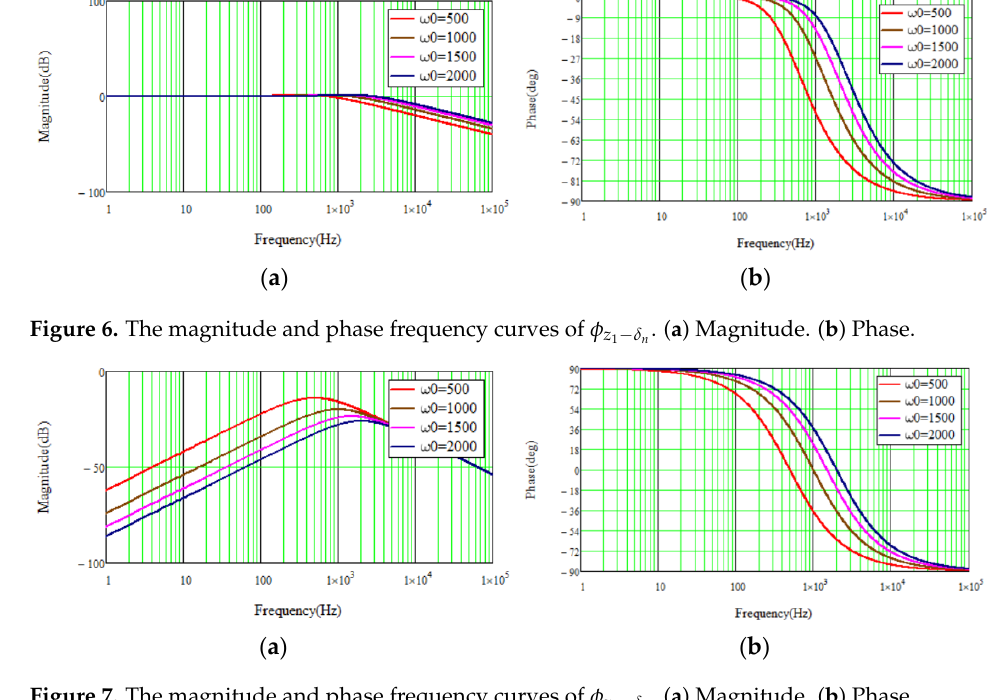
Figure 7. The magnitude and phase frequency curves of φ z